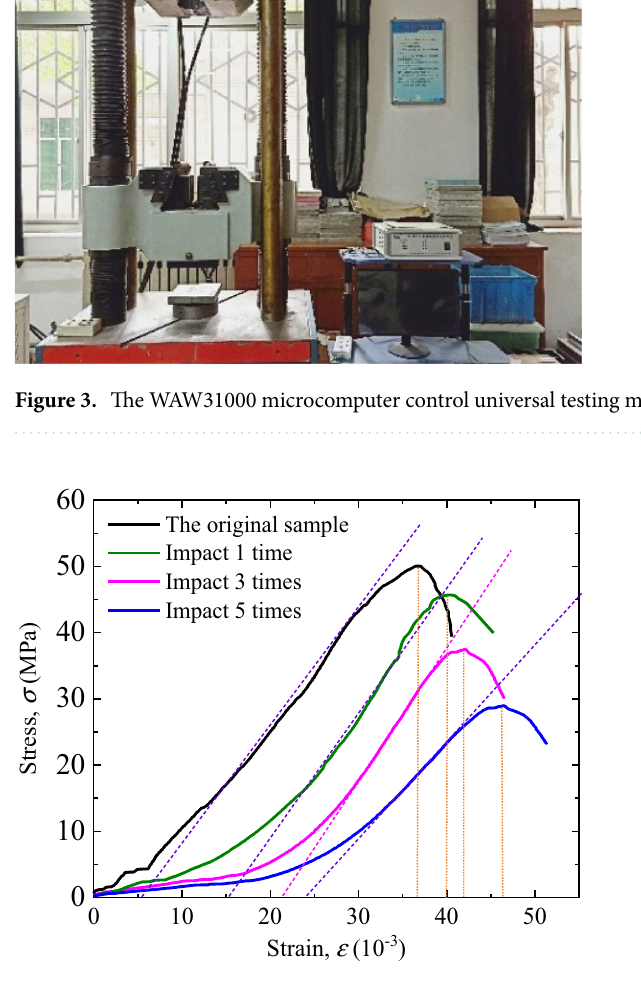
Figure 4. The Static compressive stress–strain curves of filled